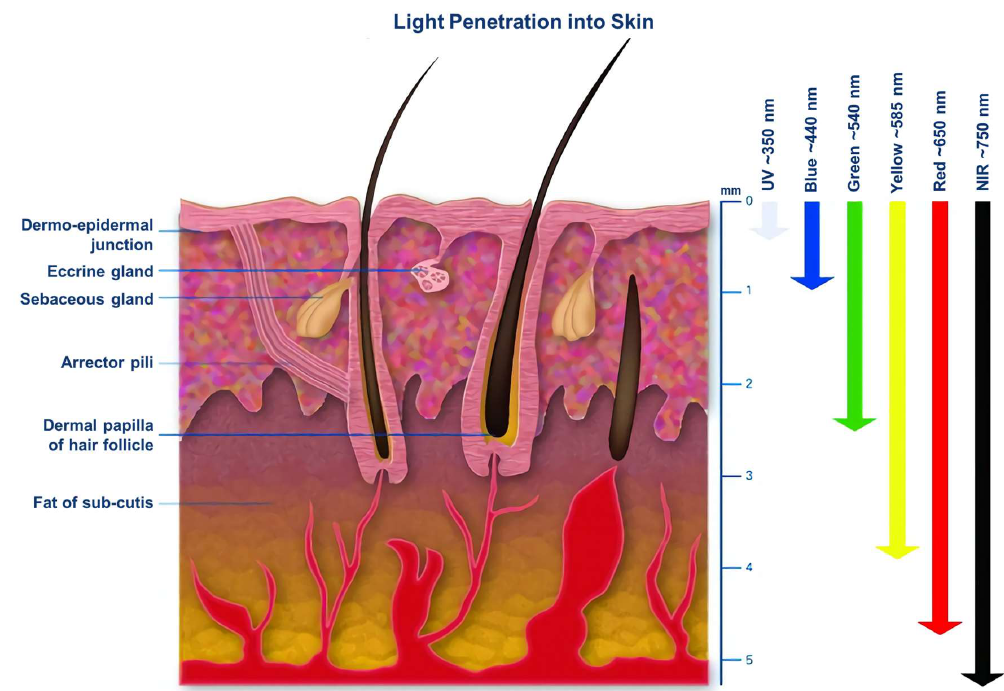
Figure 2. The tissue penetration depth of different light wavelengths [24]. Reprinted with permission from Ref [24] Copyright 2005 Taylor and Francis, Abingdon, UK.